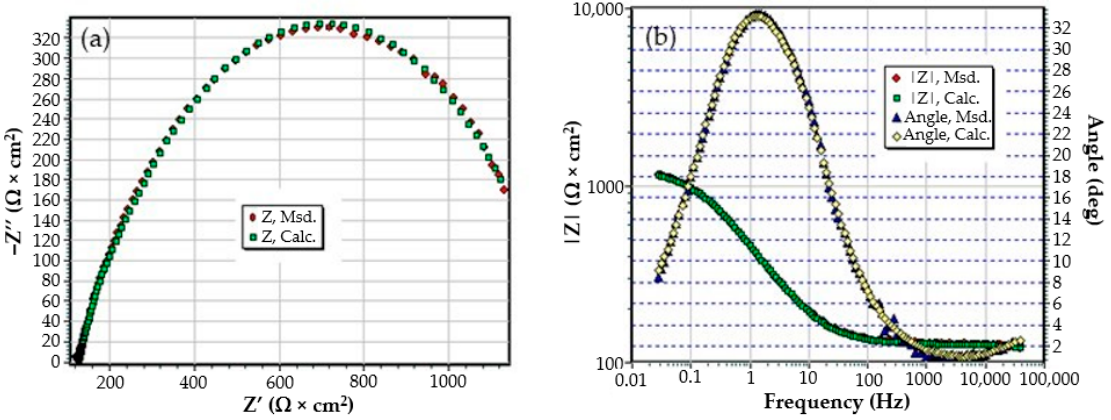
Figure A3. The Nyquist diagram ( a ) and Bode diagram ( b ) for C45 sample after 85 days of immersion in BSW.